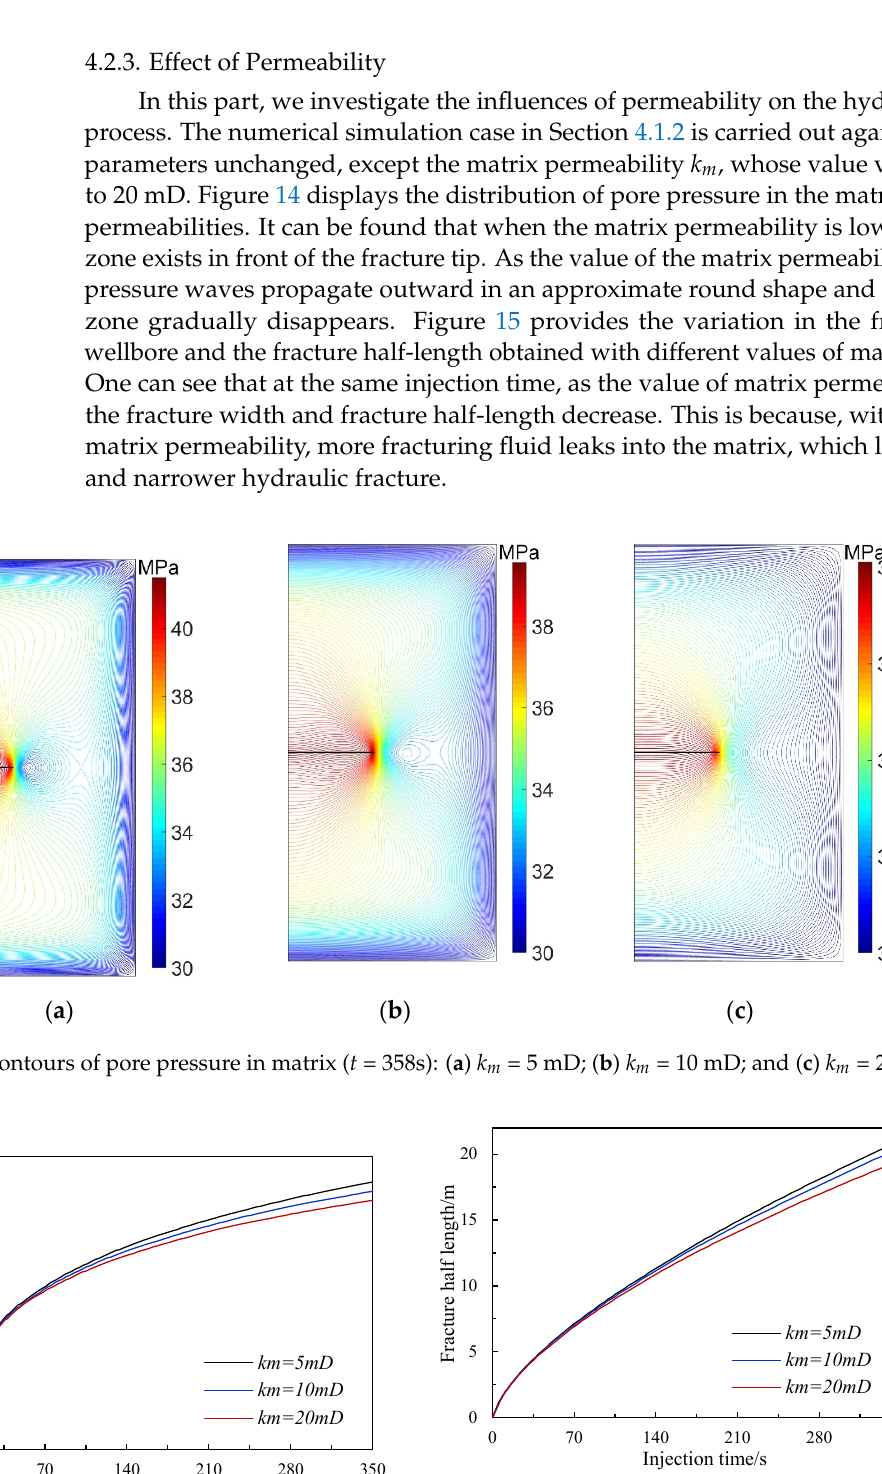
Figure 15. Numerical results with different permeabilities. ( a ) Fracture width at wellbore, and( b ) fracture half-length.